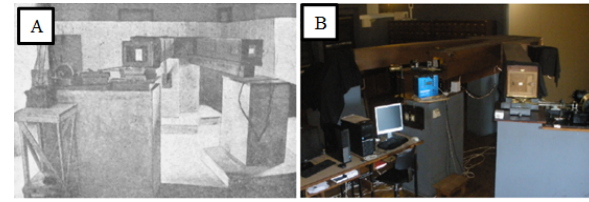
Figure 4. The spectroheliograph in 1926 (A) [Source: Lobo (1932)] and in 2019